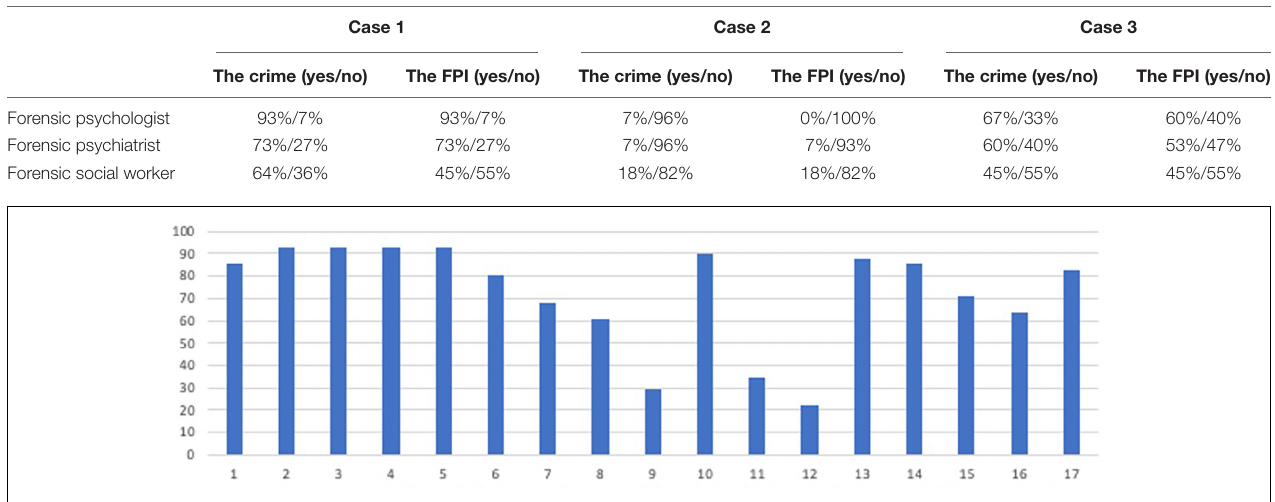
FIGURE 5 | Percentage of participants who considered the information source important in FPIs in general. p = 0.020] (see Table 3 for distributions). However, these differences were not significant after Bonferroni correction (adjusted to p = 0.008; six analyses were made). Furthermore,